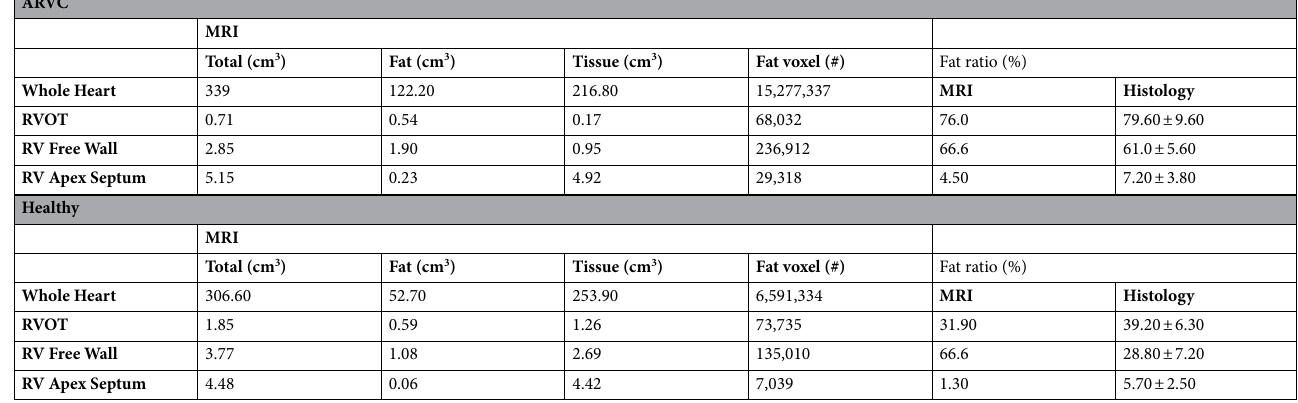
Table 1. MRI estimation of total volume of the myocardium, fat and tissue of the ARVC and the healthy hearts in the whole heart and for each region of interest of the “ARVC triangle”. Volumes are calculated from the Proton Density Fat Fraction (PDFF) map with a threshold of 40% for the ARVC and 41% for the healthy hearts. Fat ratios of each regions of interest are calculated based on MRI and histological